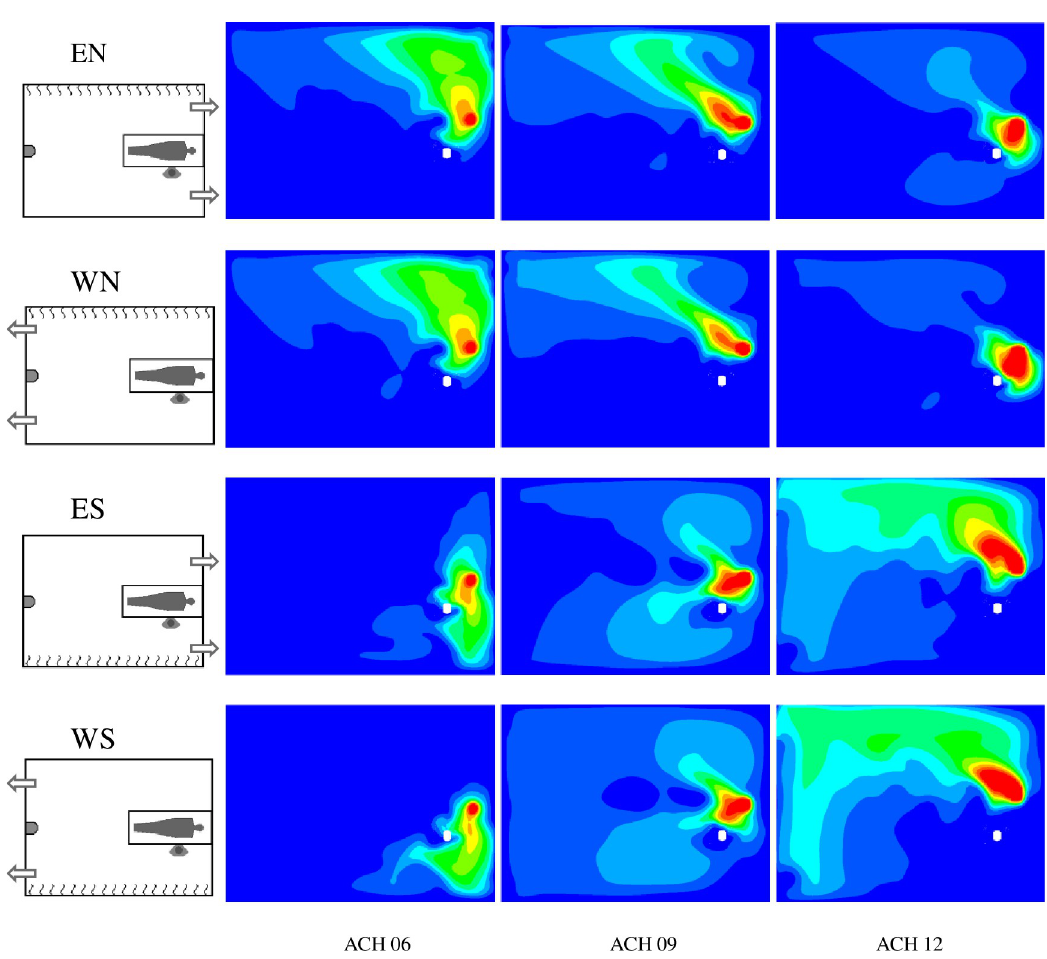
Fig 7. Contours of Y / Y PMV in a z = 1.52 m plane. Dark blue: Y < Y PMV Red: Y > 10 Y PMV .